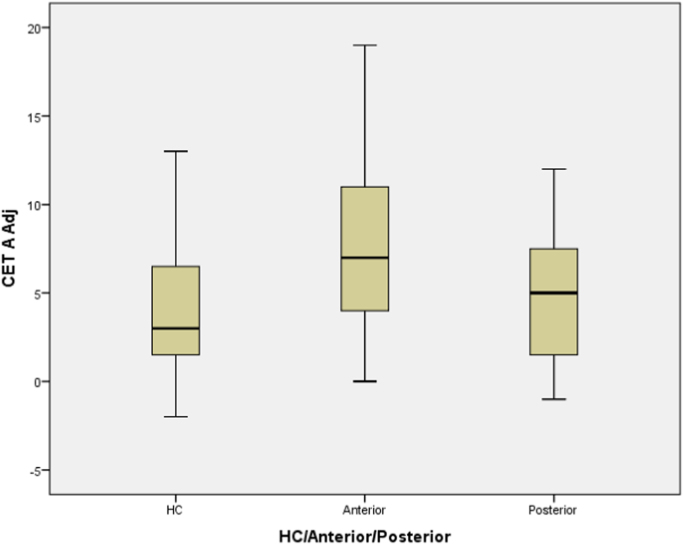
Boxplot displaying performance on CET-A Adjusted scores of Frontal, Posterior and HC.